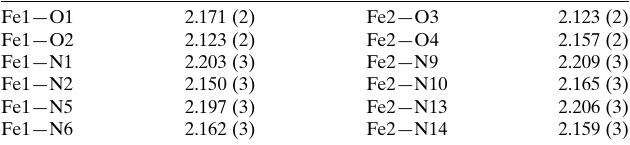
Table 1 Selected bond lengths (A˚ ).